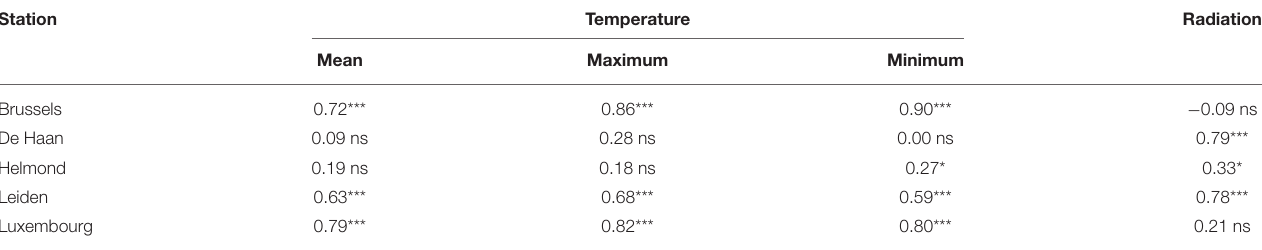
TABLE 1 | Association between the rates of change in the seasonal cycles for birch pollen concentrations and the corresponding temperature and radiation change rates.